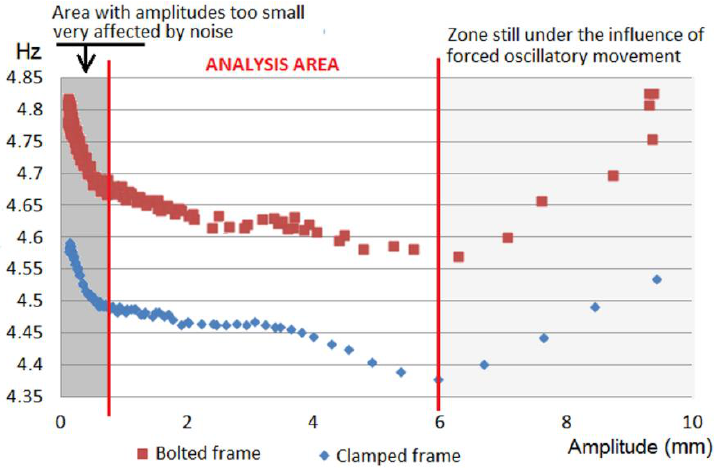
Figure 14. Comparison (bolted frame versus clamped frame) of the variation of the frame frequency-amplitude in free decay period after subjecting the frame to maximum oscillation.